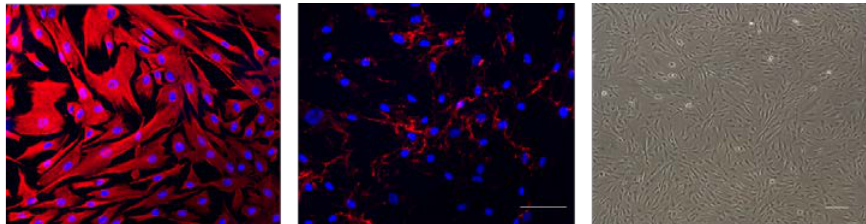
Figure 1. Immunofluorescence images showing vimentin expression (red, left) and fibronectin expression (red, middle) and nuclear staining with Hoechst 33,342 (blue) along with phase-contrast image showing fibroblast morphology (right). Scale bar = 100 µm.